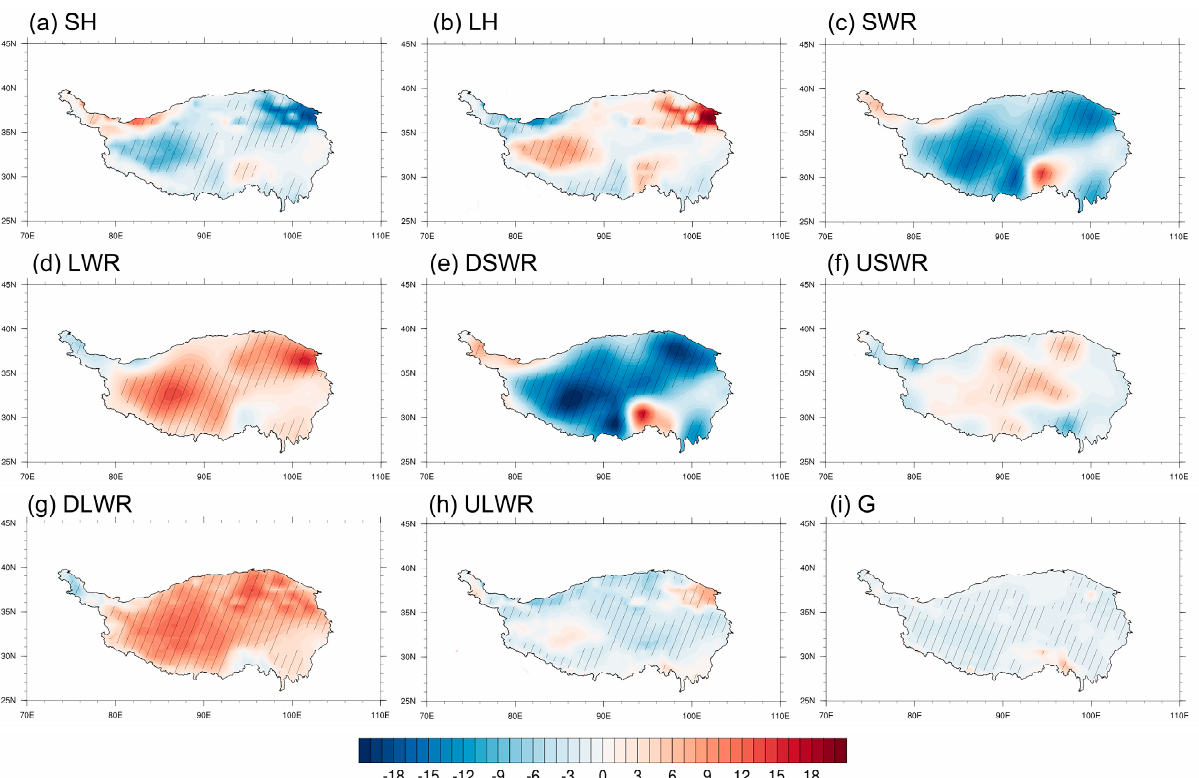
Figure 3. Spatial distribution of difference in sensible heating (SH) ( a ), latent heating (LH) ( b ), surface net shortwave radiation (SWR) ( c ), surface net longwave radiation (LWR) ( d ), downwelling surface shortwave radiation (DSWR) ( e ), upwelling surface shortwave radiation (USWR) ( f ), downwelling surface longwave radiation (DLWR) ( g ), upwelling surface longwave radiation (ULWR) ( h ), and ground heating (G) ( i ) between 1997–2018 and 1981–1995 (shading, W m − 2 ). Grid points with statistically significant anomalies passing the 95% confidence level are denoted by an oblique line.